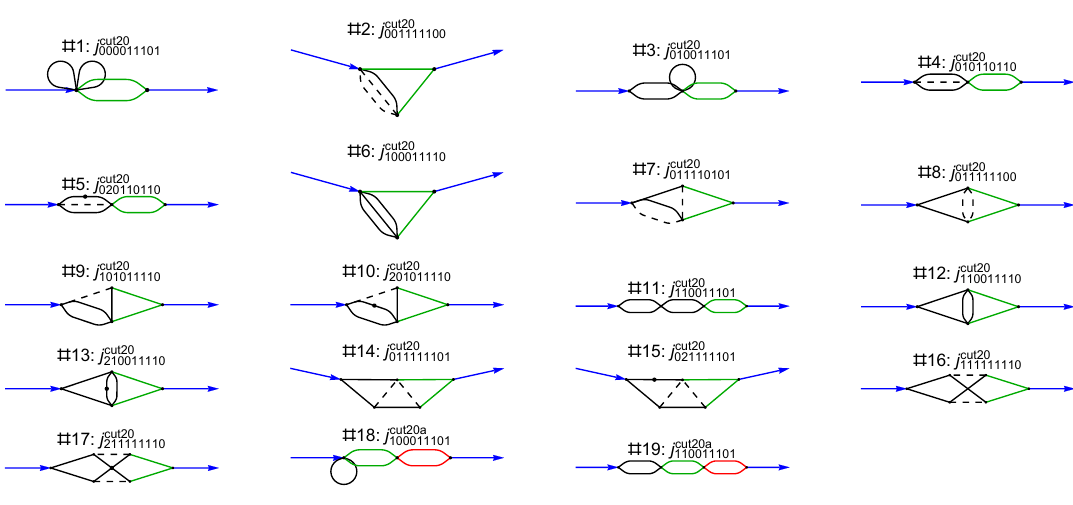
is a complex 100011101